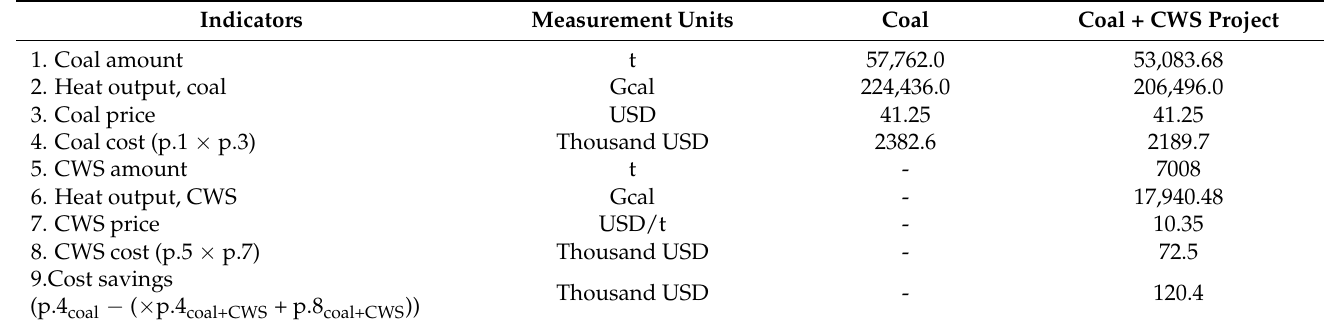
Table 3. Technical and economic indicators of the project. Source: designed by authors using [64]. Indicators